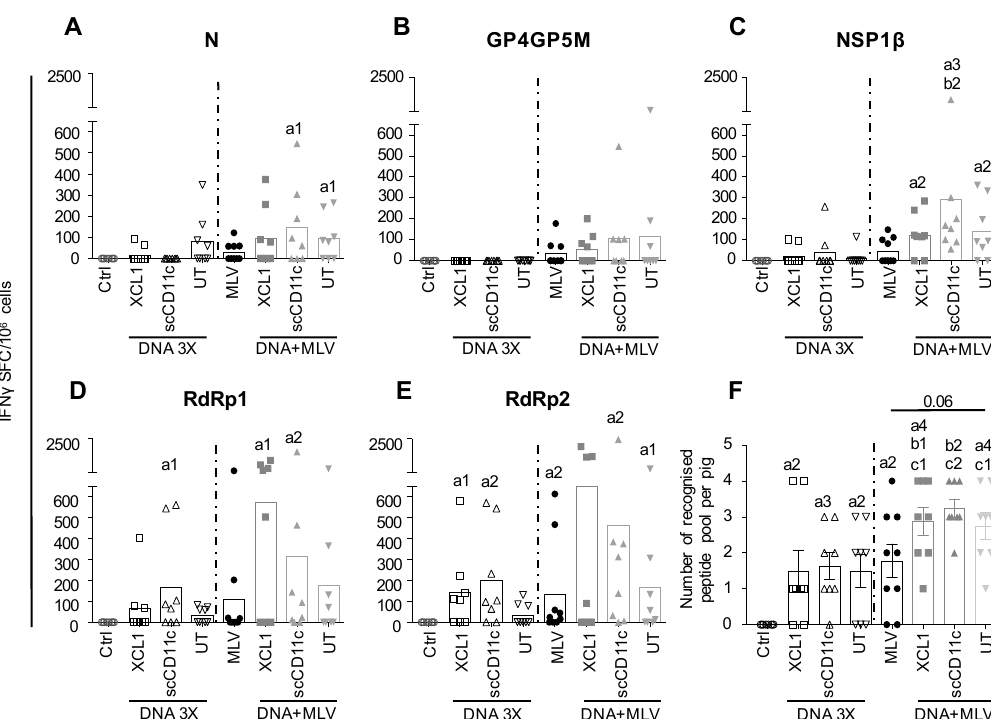
Figure 5. T-cell responses induced by DNA 3X and DNA + MLV regimens. PBMCs were collected 13 days after the last boost in the DNA 3X (D75) and DNA + MLV (D42) groups and they were analyzed for IFN γ T-cell response upon re-stimulation with overlapping peptide pools (10 µg/mL) in ELISPOT assays. ( A – E ) The responses to the N, GP4GP5M, NSP1 β , RdRp1 (peptide 1–40) and RdRp2